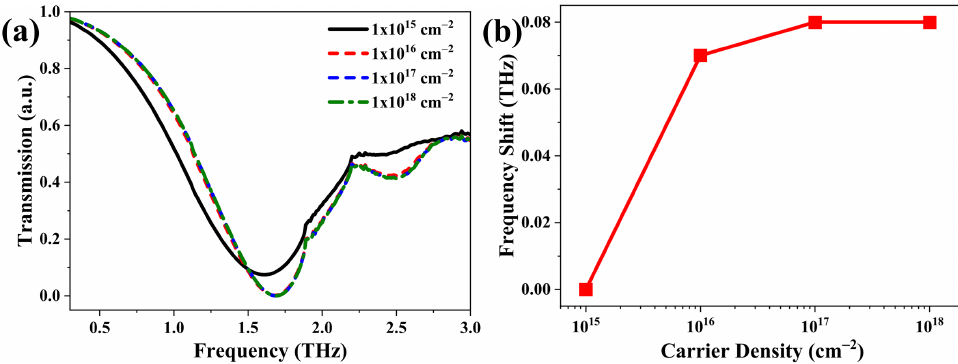
Figure 3. ( a ) Transmission spectrum with different carrier densities. ( b ) The resonance-frequency shifts versus carrier densities at the resonant frequencies of the BTR